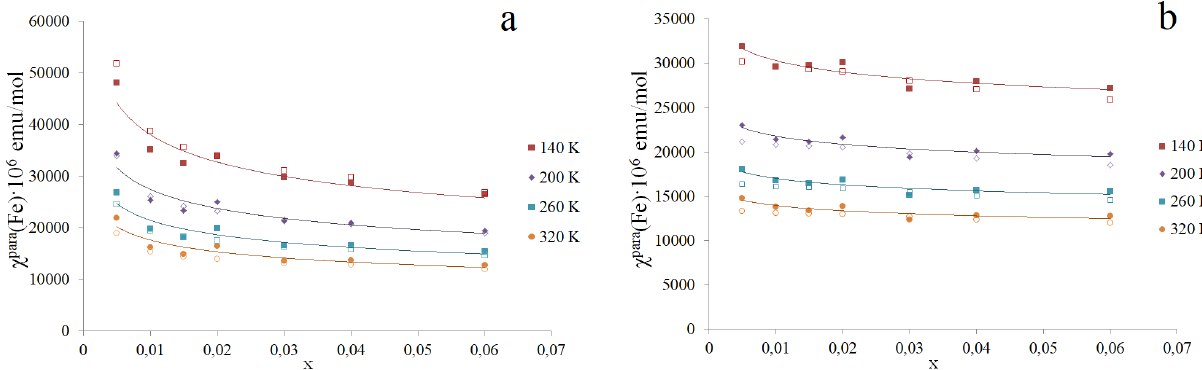
Figure 5: A compassion between calculated (open symbols) and experimental (close symbols) paramagnetic components of magnetic susceptibility for Bi 2 MgNb 2−2 x Fe 2 x O 9− δ (a) and Bi 2 Mg 1− x Fe x Nb 2 O 9+ δ (b) solid